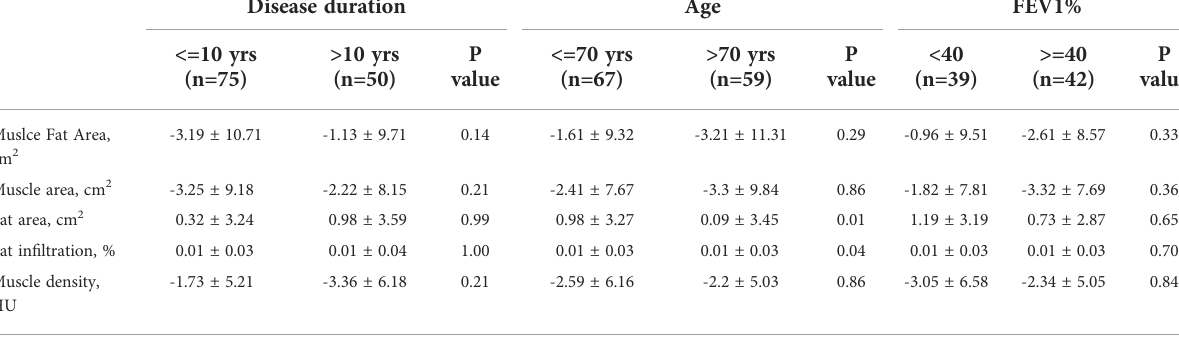
TABLE 3 Per-year change in muscle indexes in